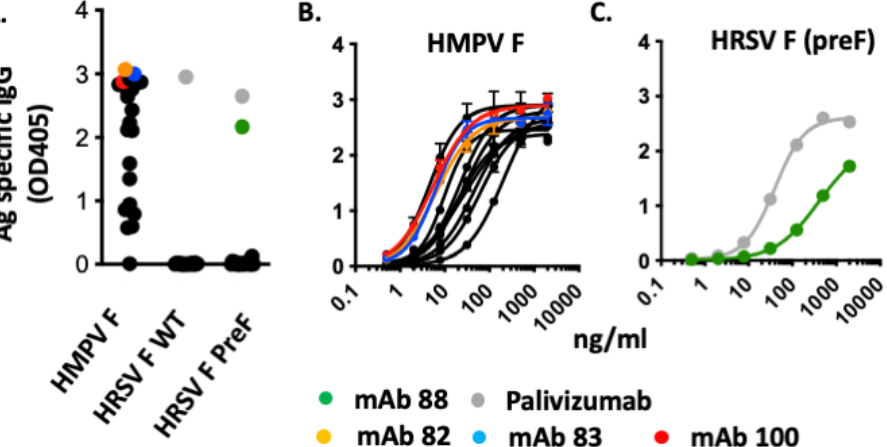
Figure 2. Binding efficiency of HMPV and RSV-specific mAbs. The binding efficiency of purified mAbs was analysed by ELISA. ( A ) MAb binding efficiency against HMPV and RSV fusion proteins was first analysed at 2 µ g/mL antibody. For RSV, binding to the wild-type (WT) and Pre Fusion (PreF) form of the fusion protein was used. MAb ( n = 21) with sufficient binding (OD above 0.5) against HMPV or RSV are depicted in black, while Palivizumab is illustrated in grey. ( B , C ) Binding affinity against HMPV and RSV fusion proteins was analysed using serial dilutions of selected mAbs (n = 12 for HMPV and n = 1 for RSV preF). mAb 82 (yellow) , mAb 83 (blue), mAb 88 (green) and mAb 100 (red) are highlighted. Palivizumab (grey) was used as positive control against RSV.